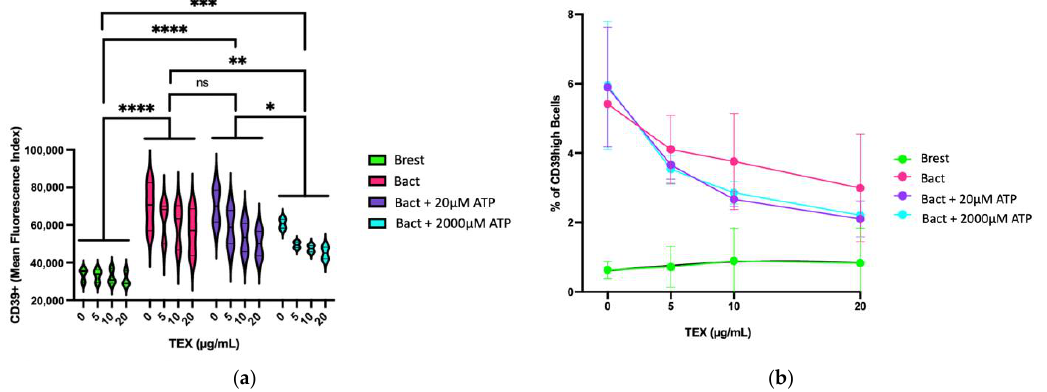
Figure 4. Flow cytometry data showing the dose-dependent influence of TEX on CD39 expression levels in activated B cells (Bact) or resting B cells (Brest) with 0, 20, or 2000 µ M ATP added. ( a ) The graph shows the CD39 mean fluorescence index of the four groups. With high significance, activation of B cells increased the overall CD39 expression on B cells as compared to Brest ( p **** < 0.0001). Further addition of 2000 µ M ATP but not 20 µ M ATP significantly reduced CD39 expression on Bact ( p ** = 0.0026). The influence of TEX within the individual groups indicated a trend toward reduced CD39 expression on B cells, especially in Bact. No change was seen in Brest. In Bact + 2000ATP co-incubated with the highest TEX concentration (20 µ g/mL), CD39 expression approximated the range seen in Brest. Brest vs. Bact + 20 µ M ATP: p **** < 0.0001; Brest vs. Bact + 2000 µ M ATP: p *** = 0.0001; Bact + 20 µ M ATP vs. Bact + 2000 µ M ATP: p * = 0.0249; ns = not significant: p > 0.05. Statistical significance was calculated using a Holm–Sidak multiple comparisons test. ( b ) Dose titration curve of B cells with TEX measured by surface CD39 expression. The graph illustrates the dose-dependent reduction in CD39high B cells through TEX which is enhanced through ATP.